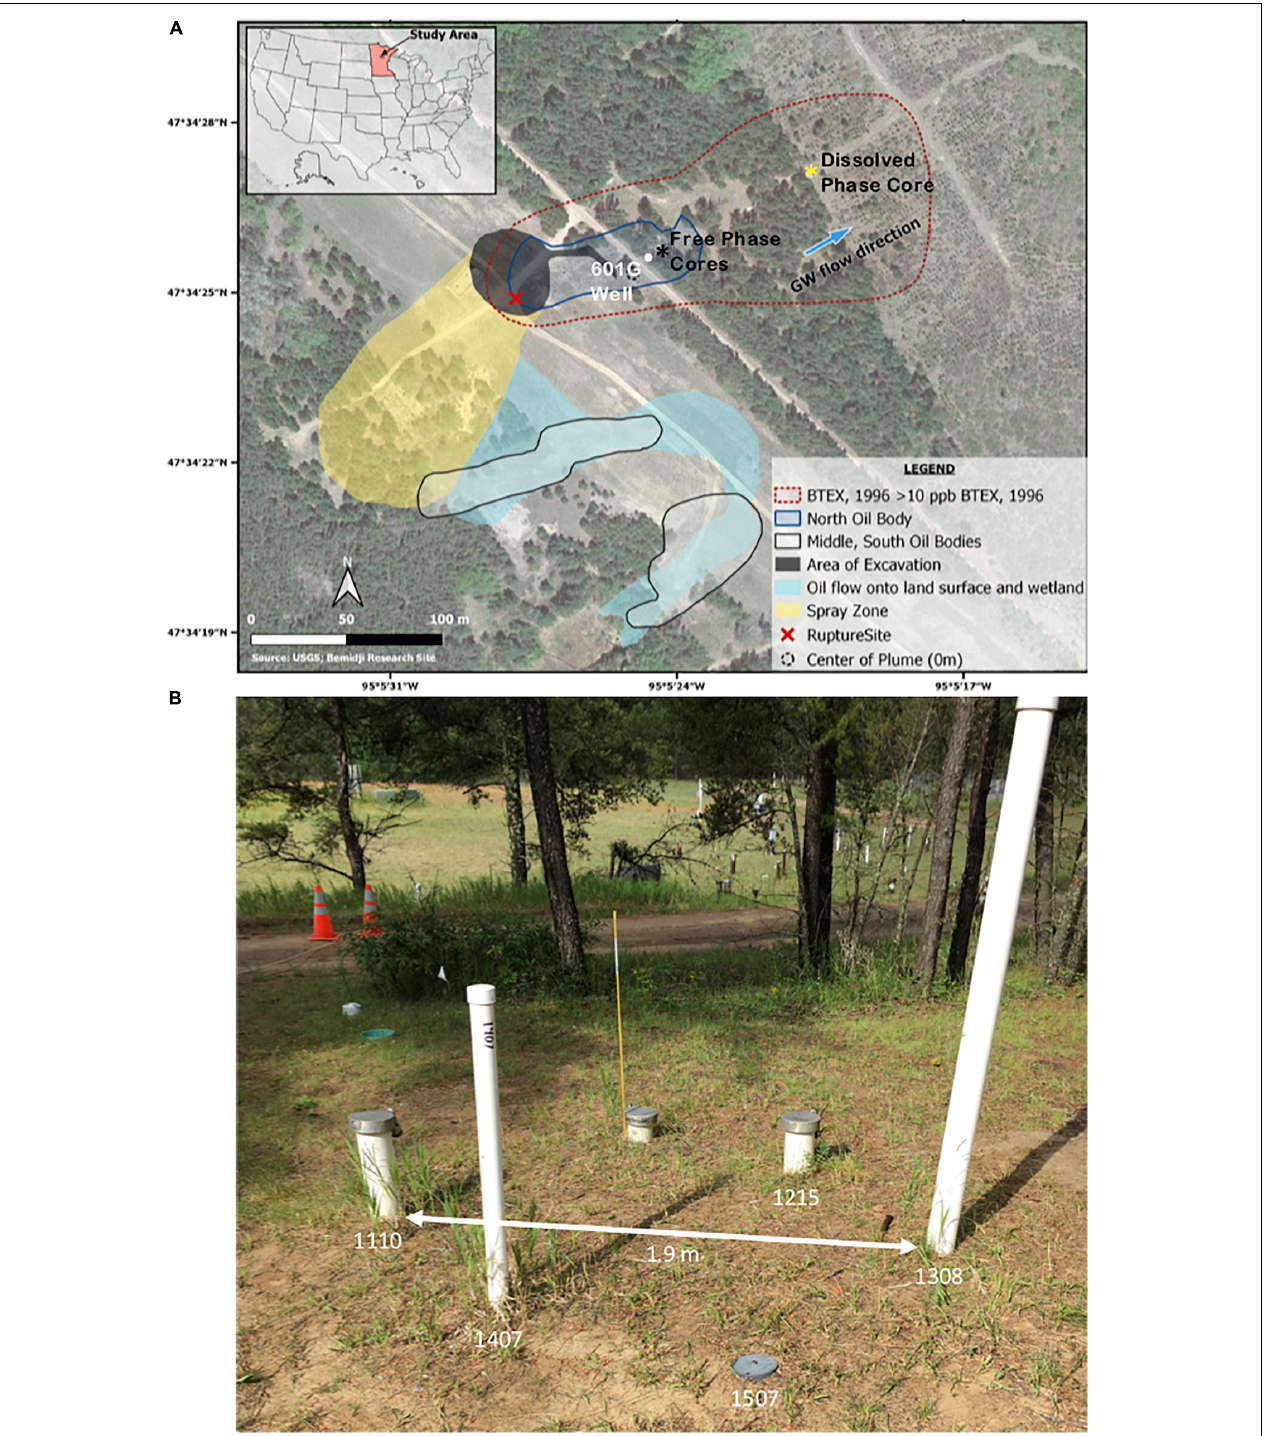
FIGURE 1 | (A) Satellite image from the National Crude Oil Spill Fate and Natural Attenuation Research Site at Bemidji, MN, overlaid with the extent of the free-phase oil and the dissolved plume as well as the location of the well and cores used in this study. The black star indicates the location of the five cores that were collected from the free-phase petroleum zone. The yellow star represents the location of the core that was collected in the dissolved-phase plume. The white dot represents the location of well 601G, which is ∼ 5 m away from the location of the cores. The blue arrow indicates the direction of the ground water (GW) flow. BTEX, benzene, toluene, ethylbenzene, xylene. The image was retrieved from the USGS Bemidji Research Site (https://mn.water.usgs.gov/projects/bemidji/spatial/ index.html) and modified. (B) Photographic image of the location of the five wells from which the free-phase cores were drilled in five consecutive years. The five wells are not more than 1.9 m